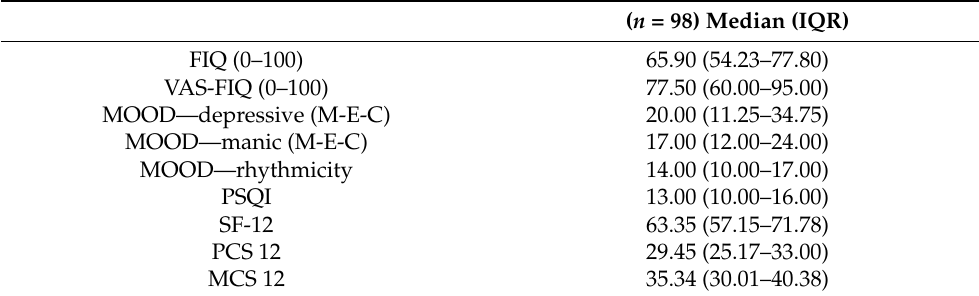
Table 2. Median values (25–75%) of the questionnaires administered to the analysed population ( n = 98).